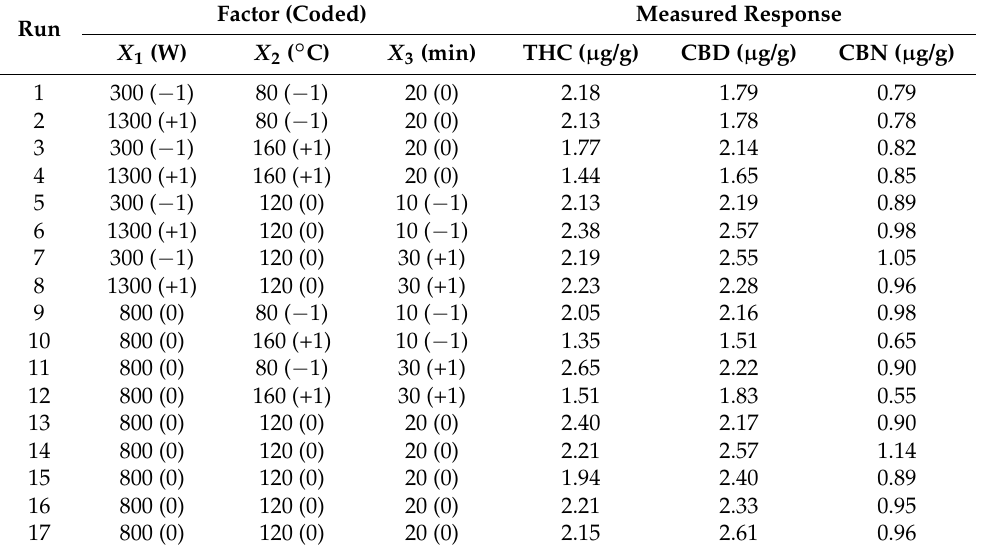
Table 1. Experimental parameters of Box–Behnken design and extraction yields of three cannabinoids.